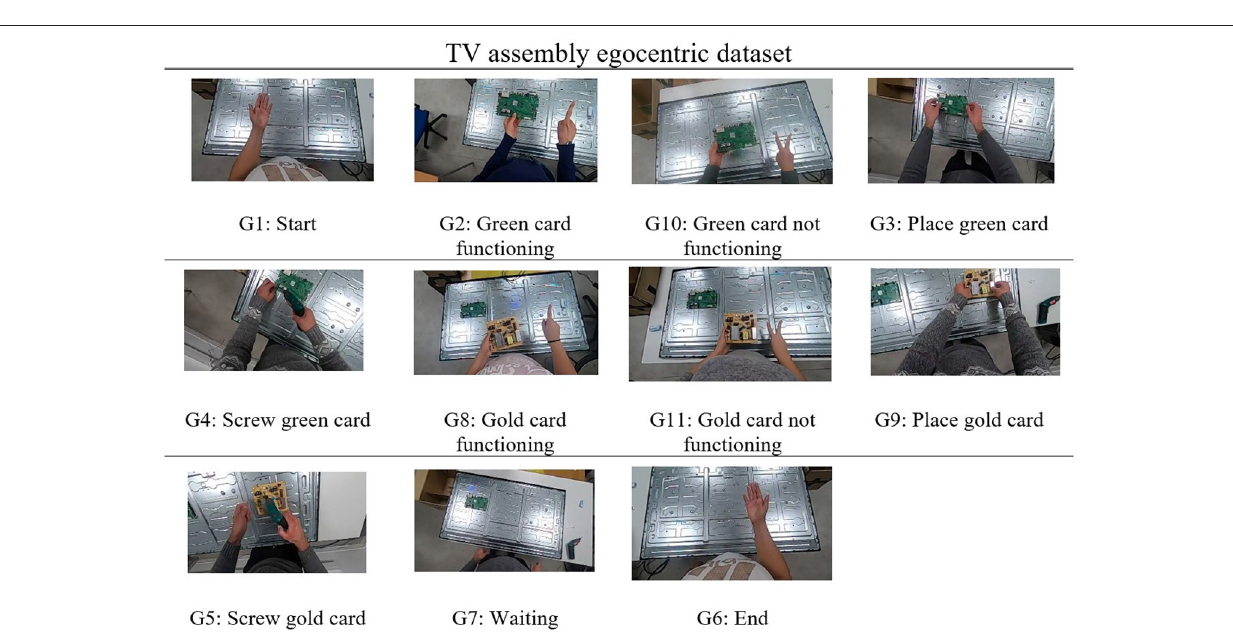
FIGURE 4 | Presentation of the TV assembly dataset, consisting of 11 classes in total, 6 gestures, and 5